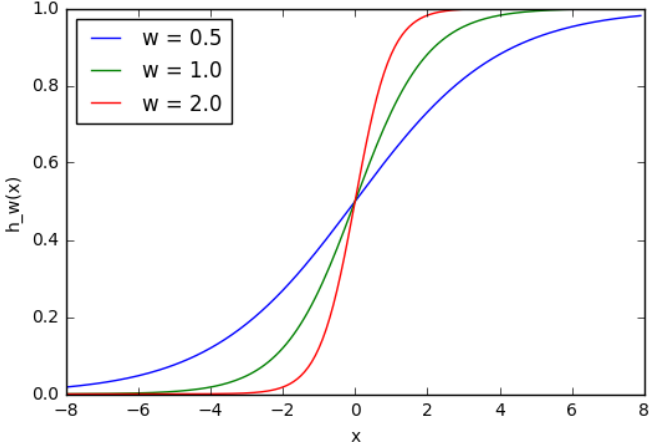
Figure 9. A sigmoid function which describes the variation of slope depending on the displacement weight.